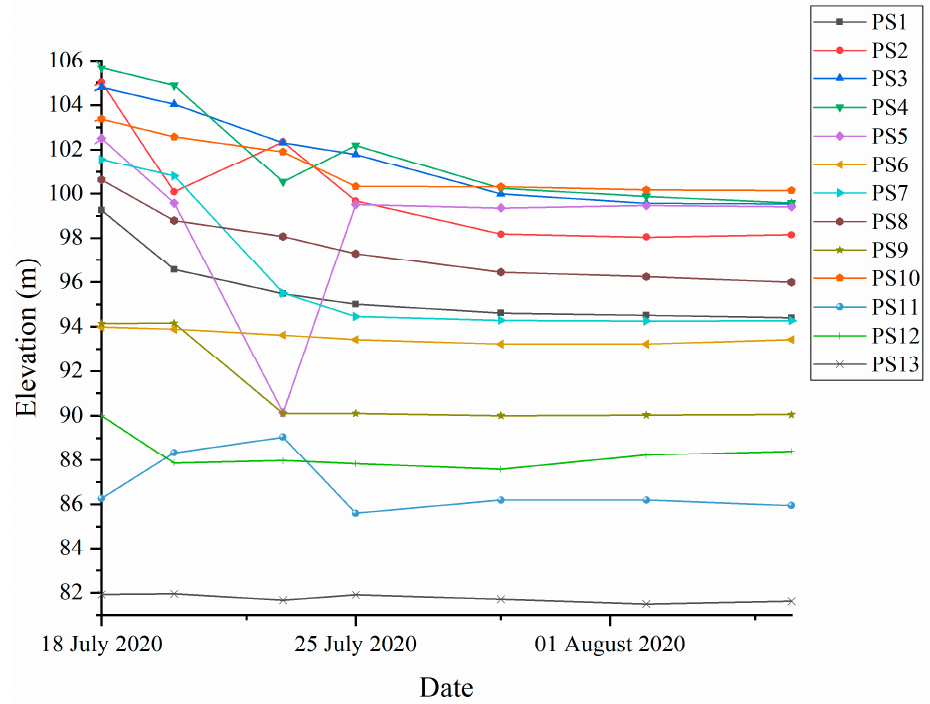
Figure 17. Variation of groundwater level from 18 July 2020 to 9 August 2020. The wellhead elevations of PS1, PS2, PS3, PS4, PS5, PS6, PS7, PS8, PS9, PS10, PS11, PS12 and PS13 are 114 m, 114.5 m, 116.5 m, 117.5 m, 115 m, 104.5 m, 109.5 m, 112 m, 109.5 m, 107 m, 90 m, 95 m and 90 m,